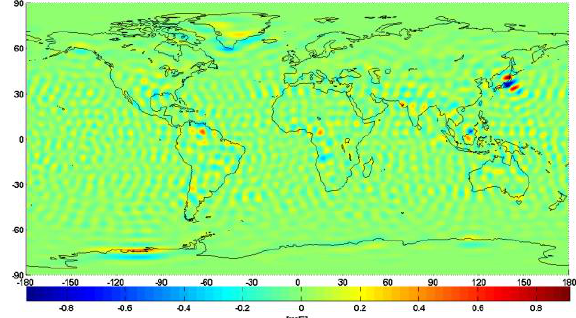
Figure 2. Northern gravity gradient changes between the two mean gravity fields without filtering (in unit of mE).